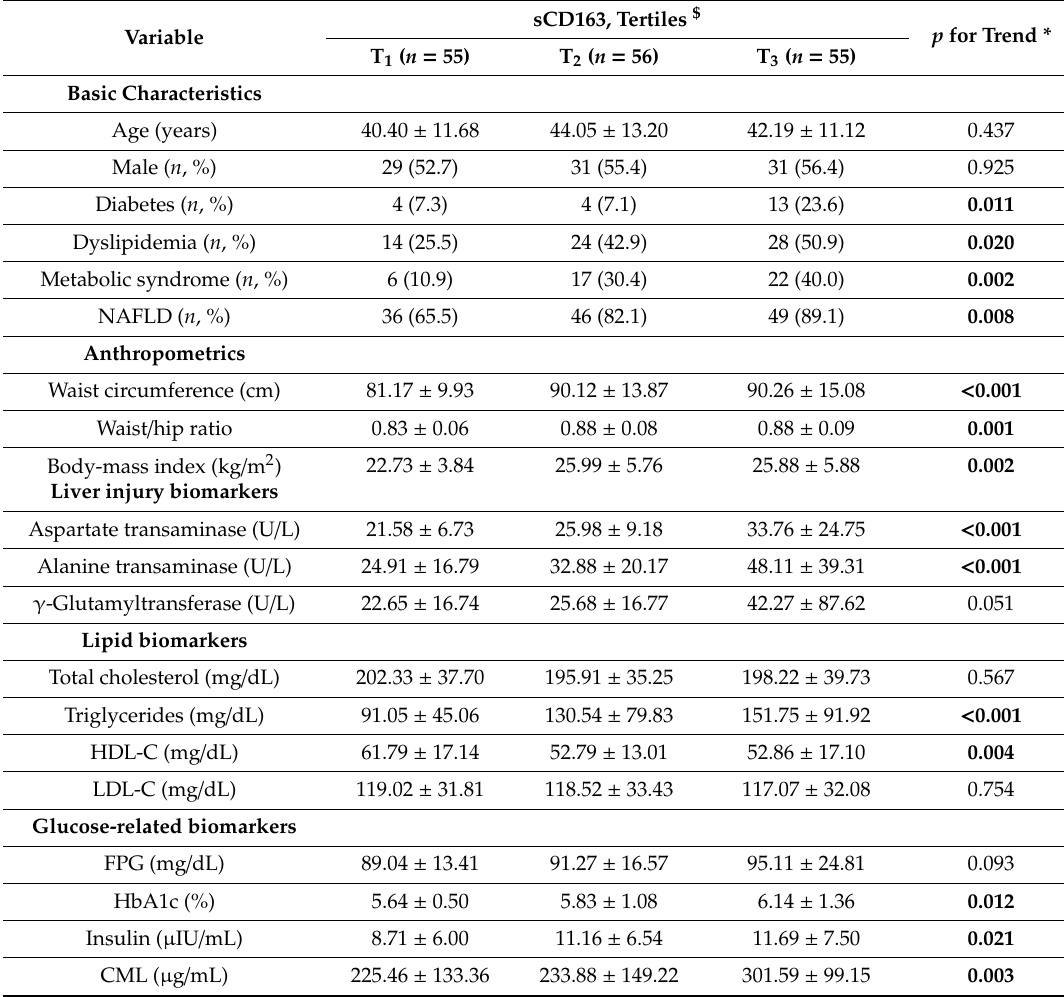
sCD163, Tertiles